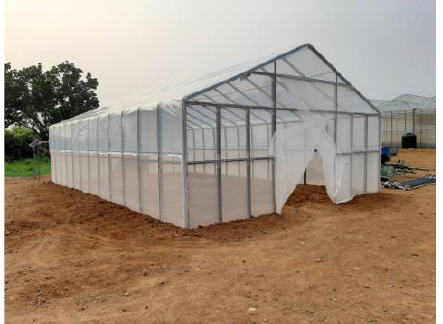
Figure 7. The completed structural frame and glazing bars.